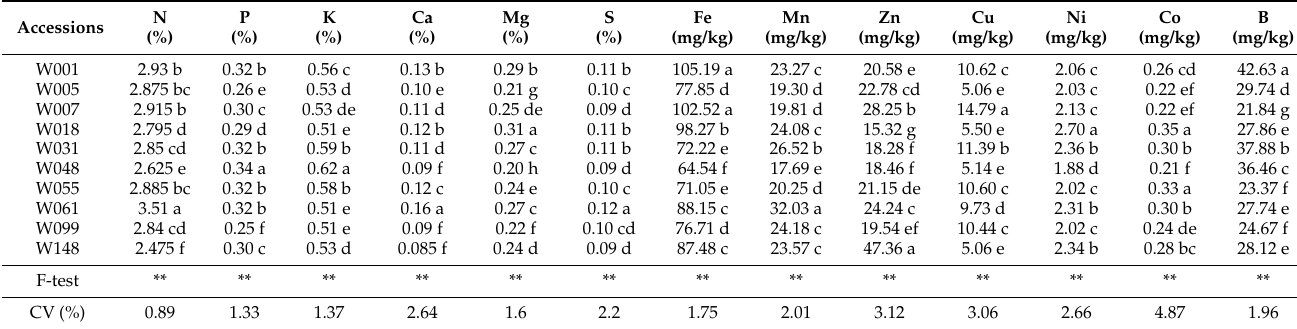
The different letter after mean within column showed significant different. ** Significant at 0.01 probability level. EE = ether extract (crude fat), CF = crude fiber, NDF = neutral detergent fiber, ADF = acid detergent fiber, GE = gross energy, and CP = crude protein. Table 5. Mineral compositions of winged bean tubers of ten accessions at Khon Kaen University in 2019.